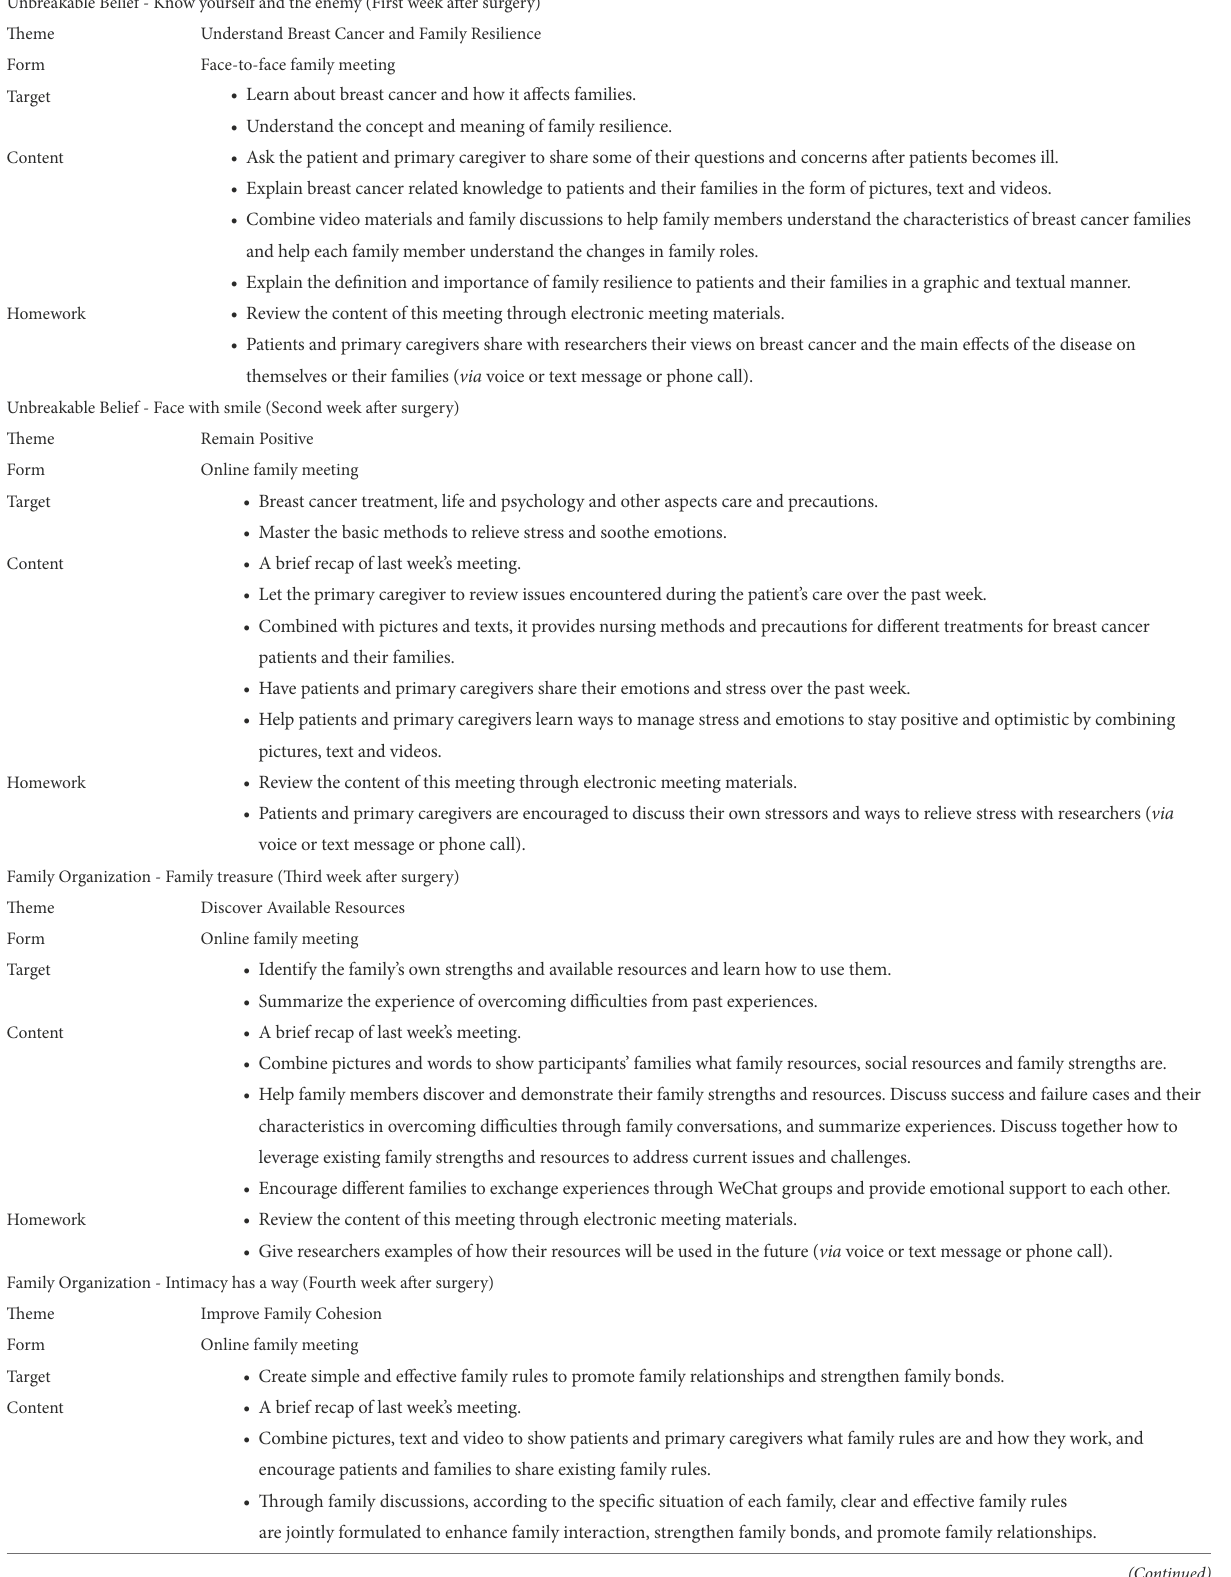
TABLE 1 Outline of the coping-focused family resilience intervention program (CFFRI). Unbreakable Belief - Know yourself and the enemy (First week after surgery) Theme Understand Breast Cancer and Family Resilience Face-to-face family